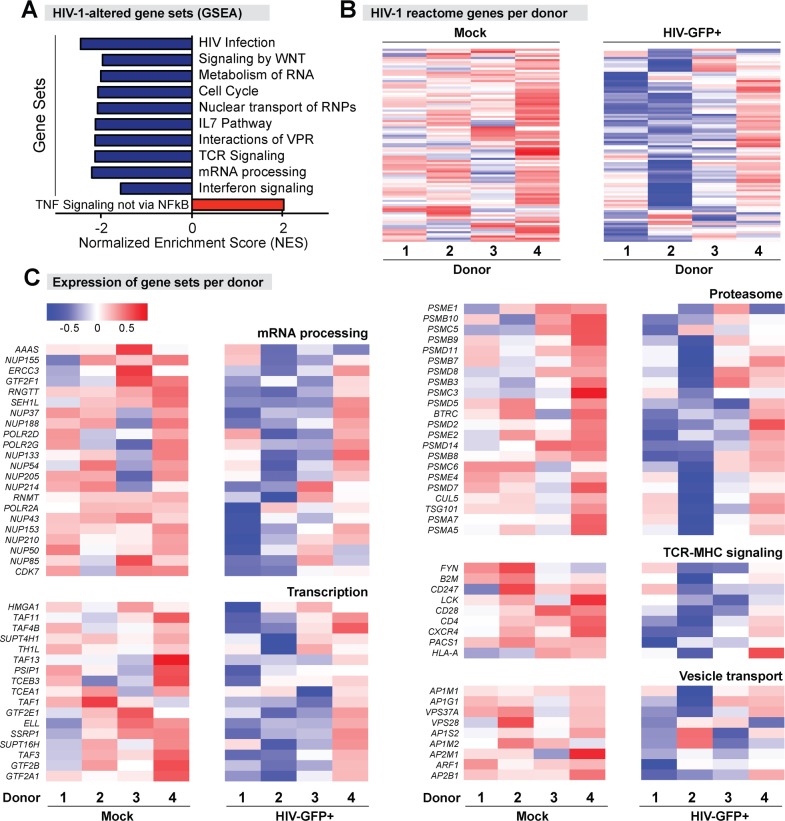
Downregulation of HIV-1 reactome genes in HIV-1-infected gut CD4+ T cells.Gene expression data were subjected to Gene Set Enrichment Analysis (GSEA). For all Panel A, blue bars/panels indicate downregulation, whereas red bars/panels indicate upregulation relative to mock. Color intensities indicate magnitudes of gene expression (log2 test/reference). (A) Top-ranked gene sets altered in HIV-1-infected gut CD4+ T cells correspond to HIV-1 reactome gene sets. (B) HIV-1 reactome genes (n = 97) from the GSEA in panel A were extracted and a heat map indicating the relative expression in the 4 different LPMC donors are shown. (C) Downregulation of HIV-1 reactome gene sets following HIV-1 infection. Heat maps of genes associated with mRNA processing, transcription, proteasome, TCR-MHC signaling and vesicle transport in HIV-1 infection are shown for each of the 4 LPMC donors analyzed.